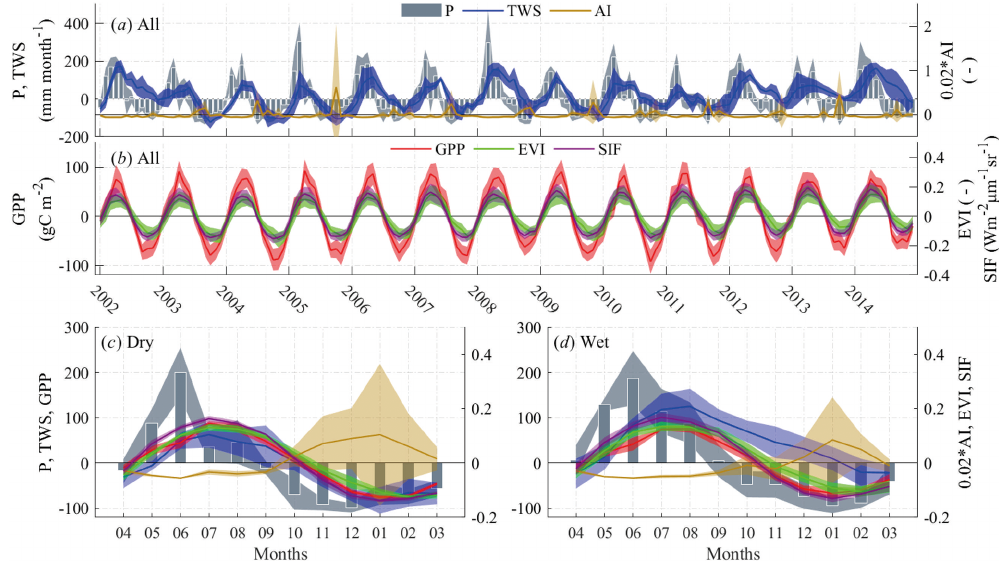
Figure 8. (a, b) Monthly variations in anomalies of precipitation ( P ), total water storage (TWS), aridity index (AI; scaled for a better view), enhanced vegetation index (EVI), gross primary production (GPP), and solar-induced chlorophyll fluorescence (SIF) in all years. (c) Monthly climatological means of the variables in dry hydrological years and (d) monthly climatological means in wet hydrological years during 2002–2014. Plots (c) and (d) share the same units and legends with plots (a) and (b) . Shaded areas show the standard errors of each variable representing the spatial